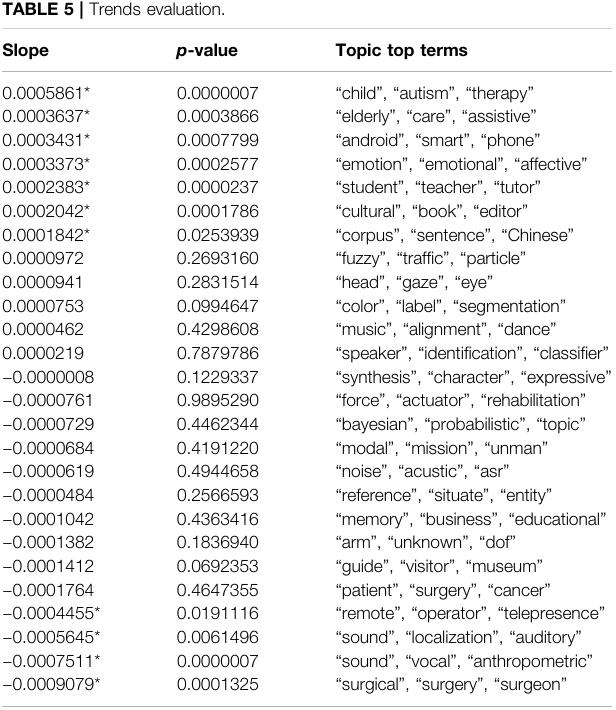
(3) Do they have any trend in the last decade?